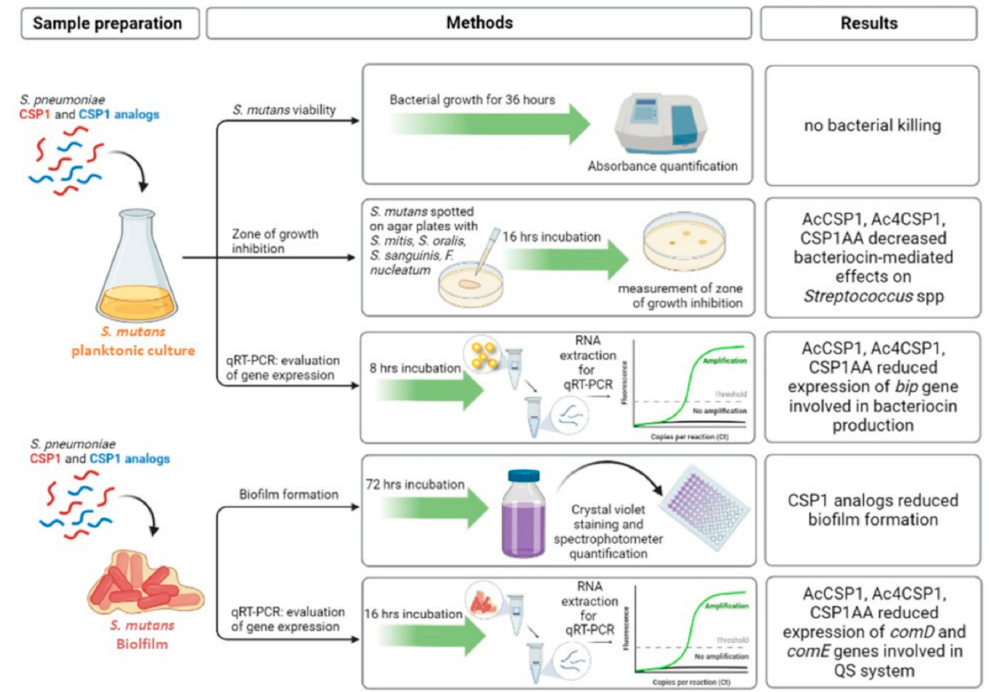
Figure 5. Schematic representation of the main experimental approaches and results obtained in the study. As indicated, S. mutans in planktonic or biofilm cultures was incubated with the natural CSP1 of S. pneumoniae or CSP1 analogs at different times. Cultures were then subjected to the measurement of cell viability by spectrophotometry, bacteriocin production by co-culture experiments, and the measurement of the zone of inhibition, biofilm evaluation, and qPCR to evaluate the expression of genes involved in the QS system.